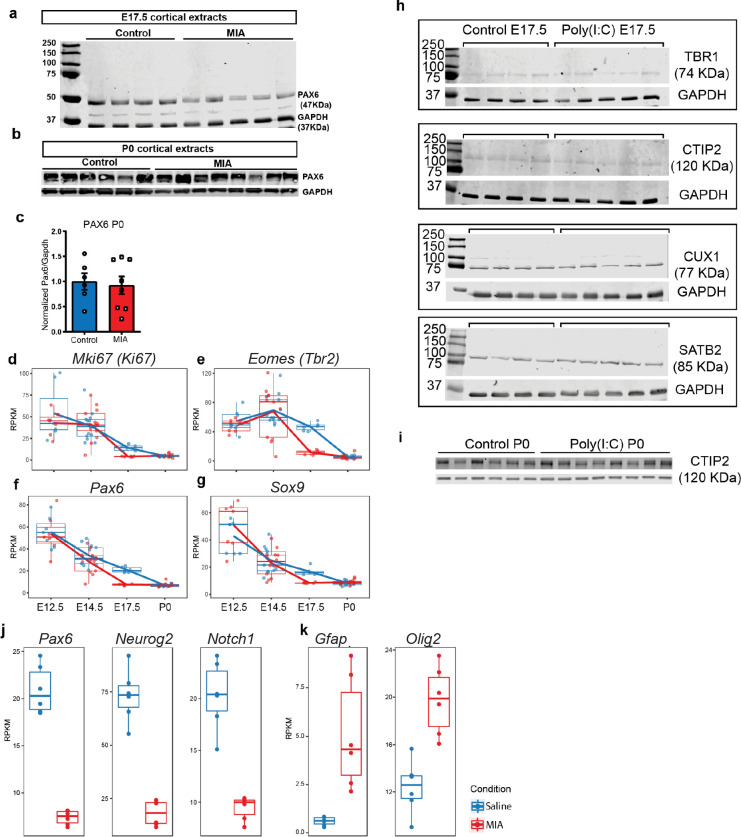
Raw western blot and RNA-seq supporting data to proliferation, lamination, and cell-specificity analyses.(a) Western blot demonstrates reduced PAX6 protein level in tissue extracts from poly(I:C) treated animals at E17.5, (b) but not at P0. (c) Quantified PAX6 protein levels from western blot analysis at P0 (n = 6 for each control and poly(I:C) groups; p=0.766, two tailed Student’s t-test). (d–g) RNA-seq RPKM expression trajectories throughout development of (d) Ki67, (e) Tbr2, (f) Pax6, and (g) Sox9. (h) Individual western blots detecting TBR1, CTIP2, SATB2 and CUX1 from whole forebrain extracts at E17.5 and (i) CTIP2 at P0. (j) E17.5 RNA-seq RPKM expression levels of Pax6, Neurog2, Notch1, and (k) Gfap and Olig2.